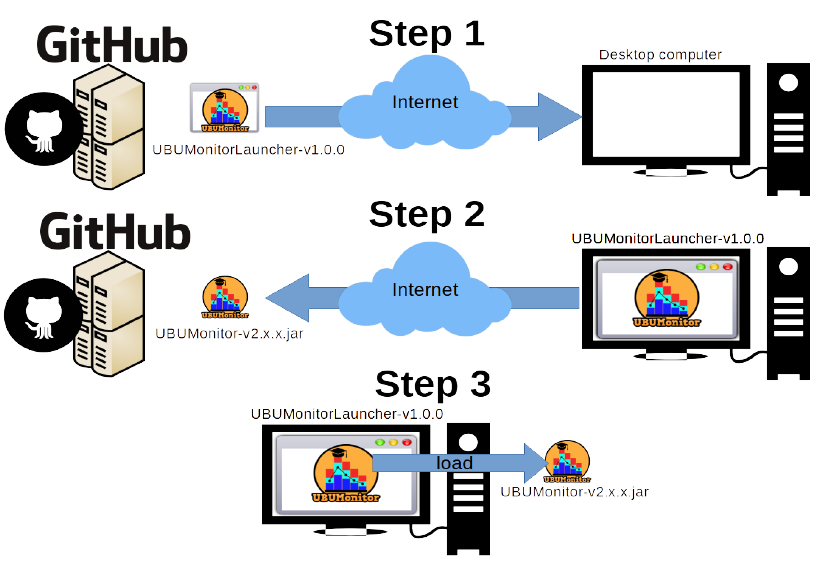
Figure 1. Distribution model with GitHub.